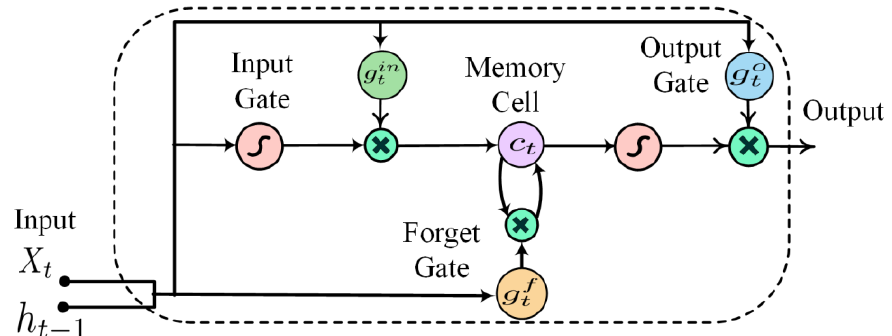
Figure 3. Basic structure of an LSTM memory unit [1].